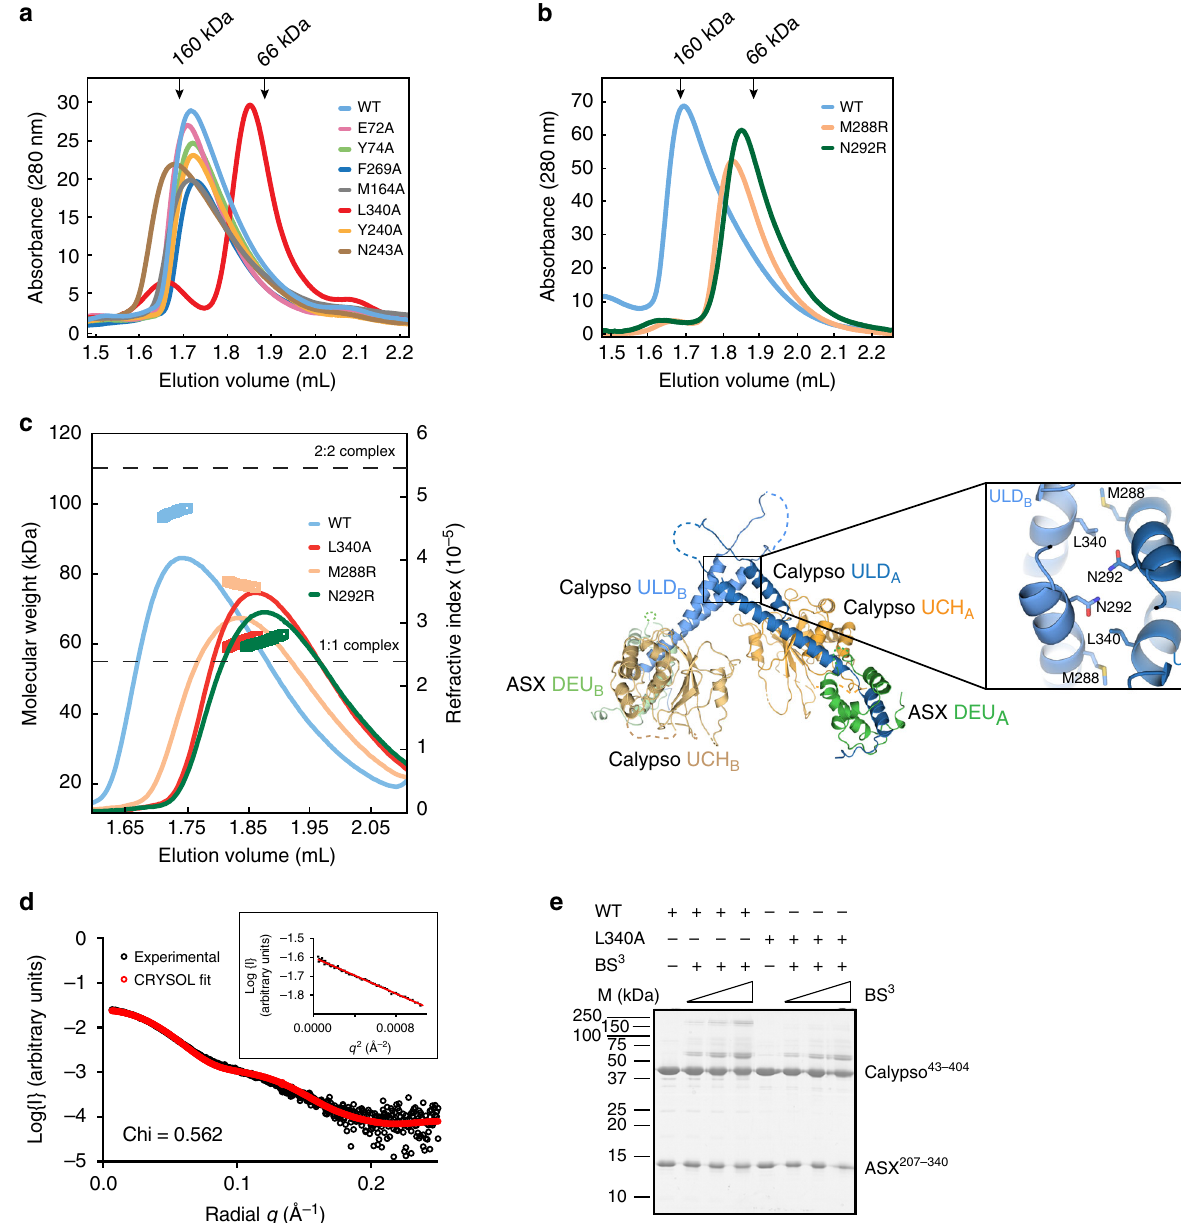
Fig. 4 The Calypso coiled-coil hairpin mediates PR-DUB oligomerisation. a Analytical size-exclusion chromatography analysis of wild type and mutant Calypso – ASX complexes. For all runs, elution pro fi les at ~30 – 50 μ M were recorded by monitoring absorbance at 280 nm. Black arrows indicate the elution pro fi les of protein standards. b Analytical size-exclusion chromatography analysis of wild type, M288R and N292R Calypso – ASX proteins. Experiments were performed and recorded as described in a . Black arrows indicate the elution pro fi les of protein standards. c SEC-MALLS analysis of wild type and mutant Calypso – ASX complexes. Elution pro fi les of each protein complex at 50 μ M monitored by differential refractive indices (lines); the weight averaged molecular masses (Mw) are shown with symbols. Dashed lines correspond to the size of the 1:1 (55 kDa, bottom) and 2:2 (110 kDa, top) Calypso – ASX complex (left). Cartoon representation of the Calypso – ASX complex (right), coloured as in Fig. 1b. A close-up view showing the packing of the two coiled- coil hairpins, with residues that mediate dimerisation indicated (see Supplementary Fig. 5a, b). d Overlay of experimental SAXS data (black circles) and scattering pro fi le calculated using CRYSOL (ref. 59 ) for the crystal structure of Calypso – ASX. Agreement between the experimental data and calculated scatter pattern is signi fi ed by Chi = 0.562 (see Supplementary Fig. 5a, f, g, and Supplementary Table 5). e Assays comparing the appearance of crosslinked species in wild type and L340A Calypso – ASX complexes at increasing concentrations of BS 3 . Samples were resolved by reducing SDS-PAGE gel and stained with Coomassie Blue. BS 3 , bis(sulfosuccinimidyl)suberate (see Supplementary Fig.